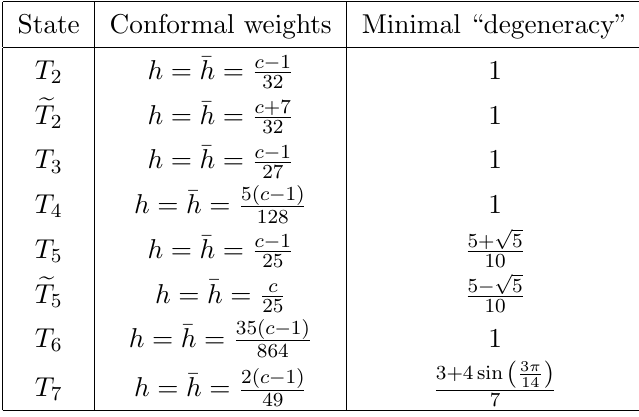
Table 1. Minimum number of scalars we need to add to render the MWK partition function